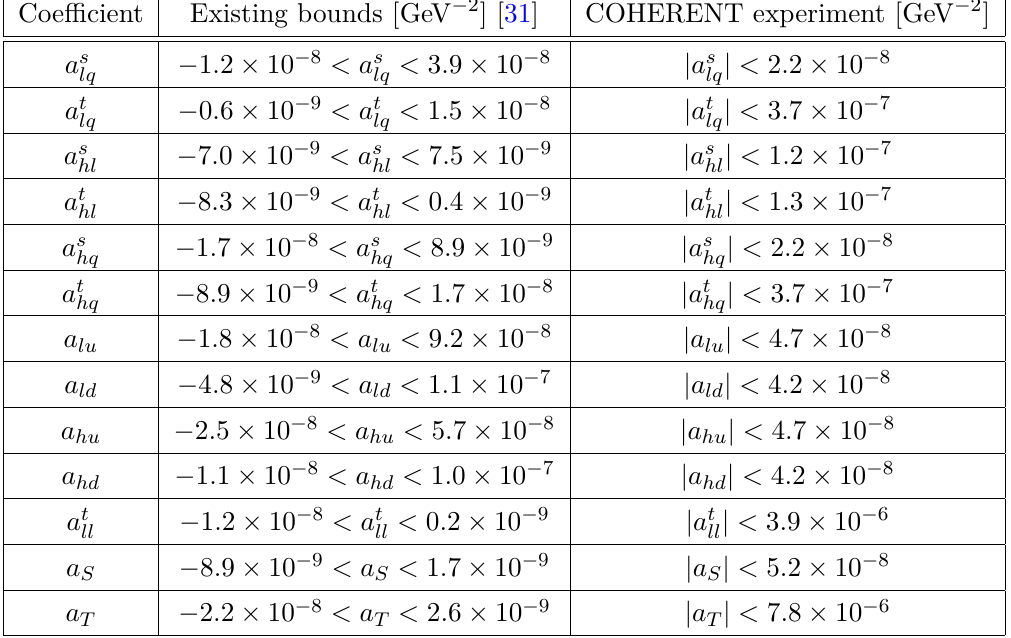
Table 4 . Comparison between present limits and the ones obtained from COHERENT at 90% C.L., taking one parameter at a